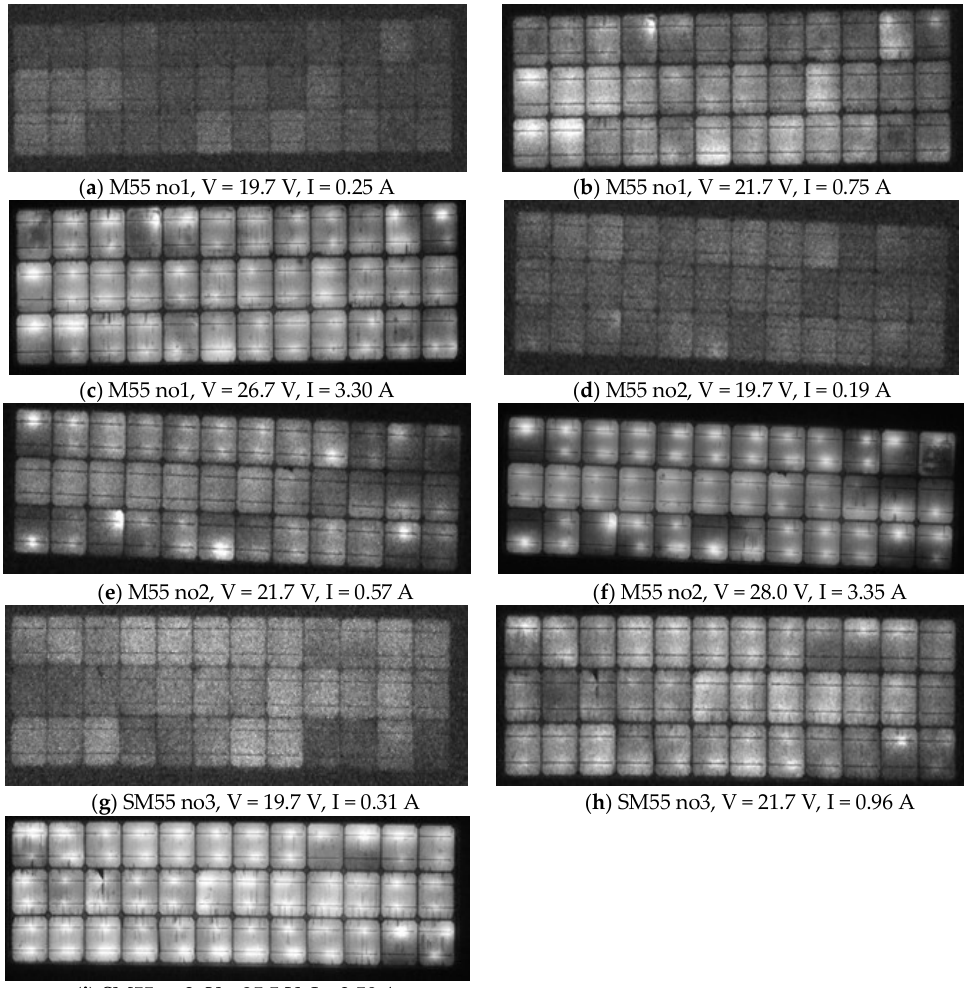
Figure 12. EL images of M55 ( a – c ) module no1, ( d – f ) module no2, and ( g – i ) module no3. The bias V and the allowed I are shown for each case.